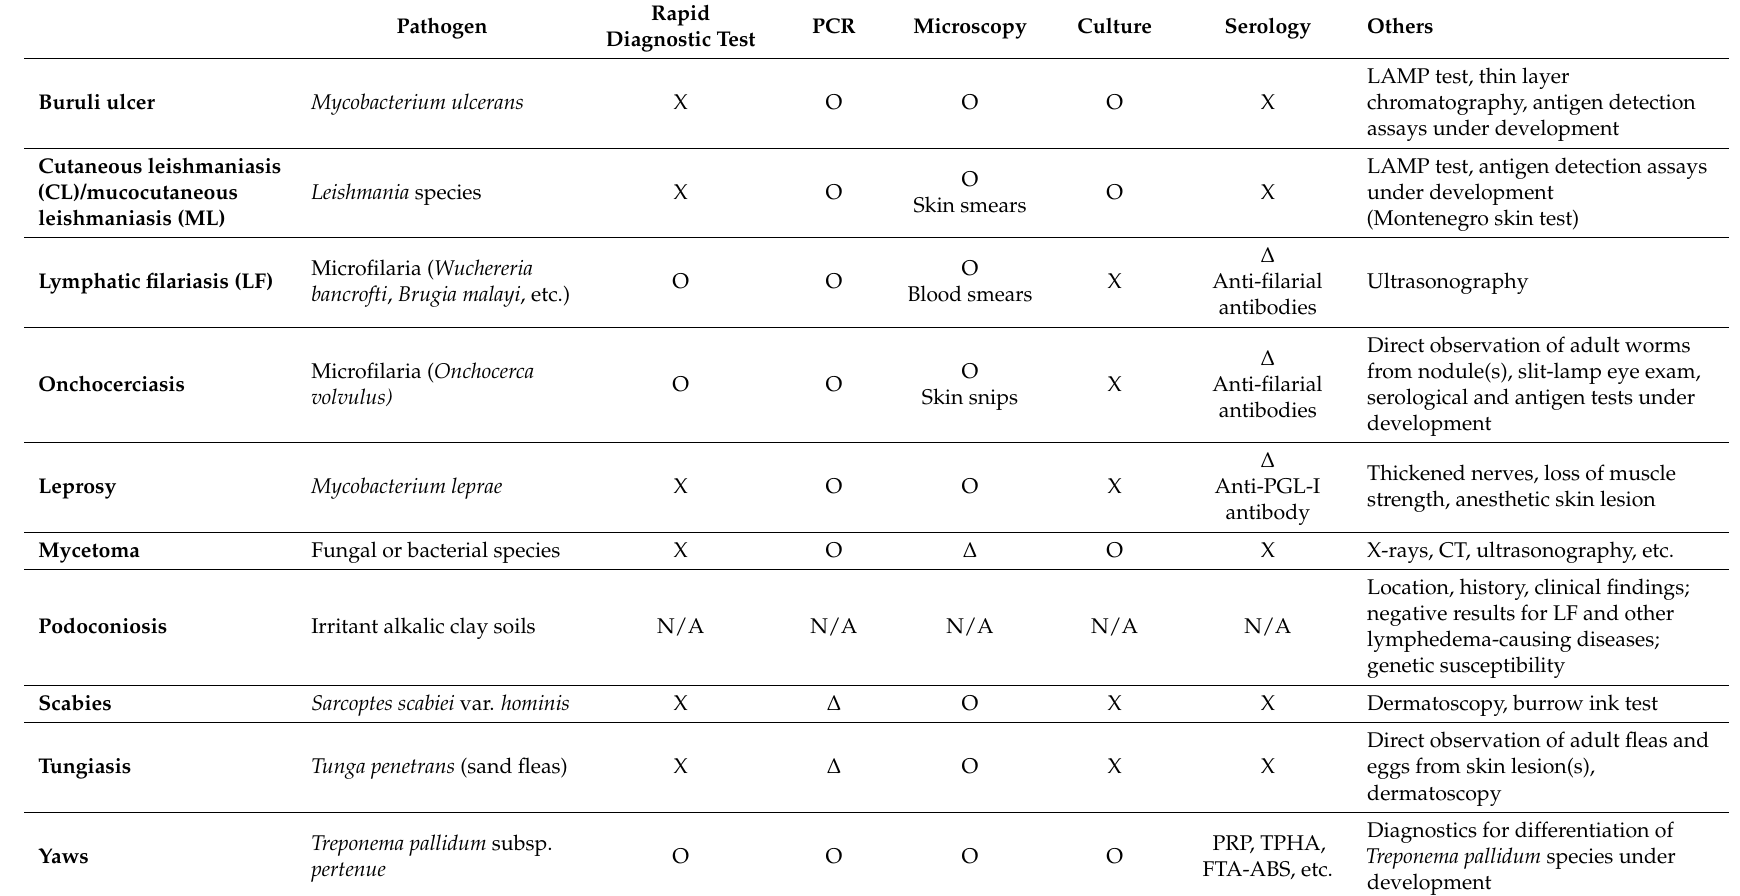
Table 1. Diagnostic methods and tools for skin